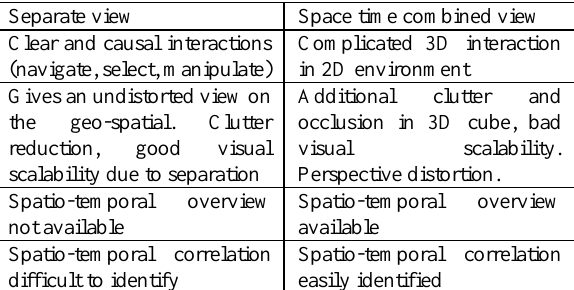
Table 2. The difference between the separate view and space